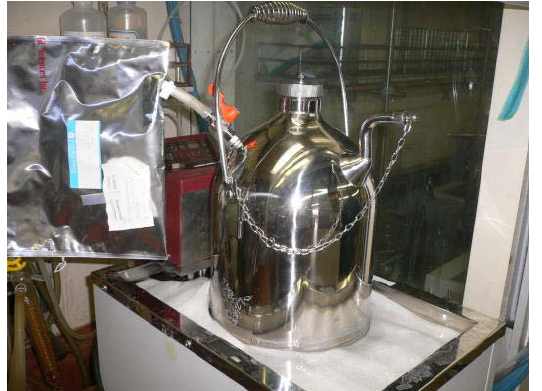
Figure 3. Preincubation of the sludge in stainless steel